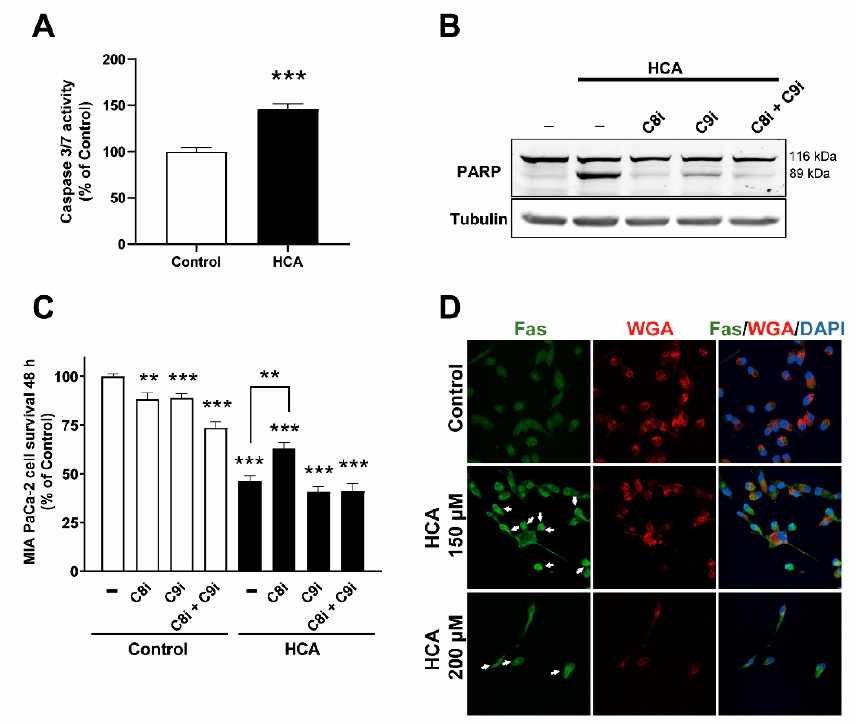
Figure 3. HCA enhances Caspase-3/-7 activity and induces apoptosis in pancreatic cancer cells mainly through the extrinsic pathway. ( A ) Caspase 3/7 activity was measured in MIA PaCa-2 cells as a luminescence read-out (Caspase-3/7 Glo assay) after incubation with HCA (200 µ M for 48 h: the bars correspond to the mean ± SEM values of 2 independent experiments performed in triplicate). ( B ) Representative immunoblot of the effects of C8i (inhibitor zIETD-fmk, 50 µ M), C9i (inhibitor zLEHD-fmk, 50 µ M), and C8i+C9i (zIETD-fmk+zLEHD-fmk, 50 + 50 µ M) on PARP proteolysis in MIA PaCa-2 cells treated with HCA for 48 h. MIA PaCa-2 cells were pretreated with the inhibitors for 1.5 h before exposure to HCA (200 µ M). ( C ) Effects of C8i, C9i, and C8i+C9i on the survival of MIA PaCa-2 cells treated for 48 h with HCA (the bars correspond to the mean ± SEM of three indepen- dent experiments performed in triplicate). ( D ) Labelling of the Fas receptor (green) and Wheat germ agglutinin (red) in MIA PaCa-2 cells cultured for 48 h in the presence or absence of HCA (150 and 200 µ M). Capping of the Fas receptors is indicated with arrows. Scale bar 4 µ M. Student’s t -test: ** p < 0.01, *** p < 0.001 with respect to the controls. HCA, 2-hydroxycervonic acid; C8i, caspase 8 inhibitor (zIETD-fmk); C9i, caspase 9 inhibitor (zLEHD-fmk); C8i+C9i, caspase 8 inhibitor + caspase 9 inhibitor (zIETD-fmk+zLEHD-fmk); PARP, Poly (ADP-Ribose) Polymerase; WGA, Wheat germ agglutinin; –, the absence of the drug indicated in the